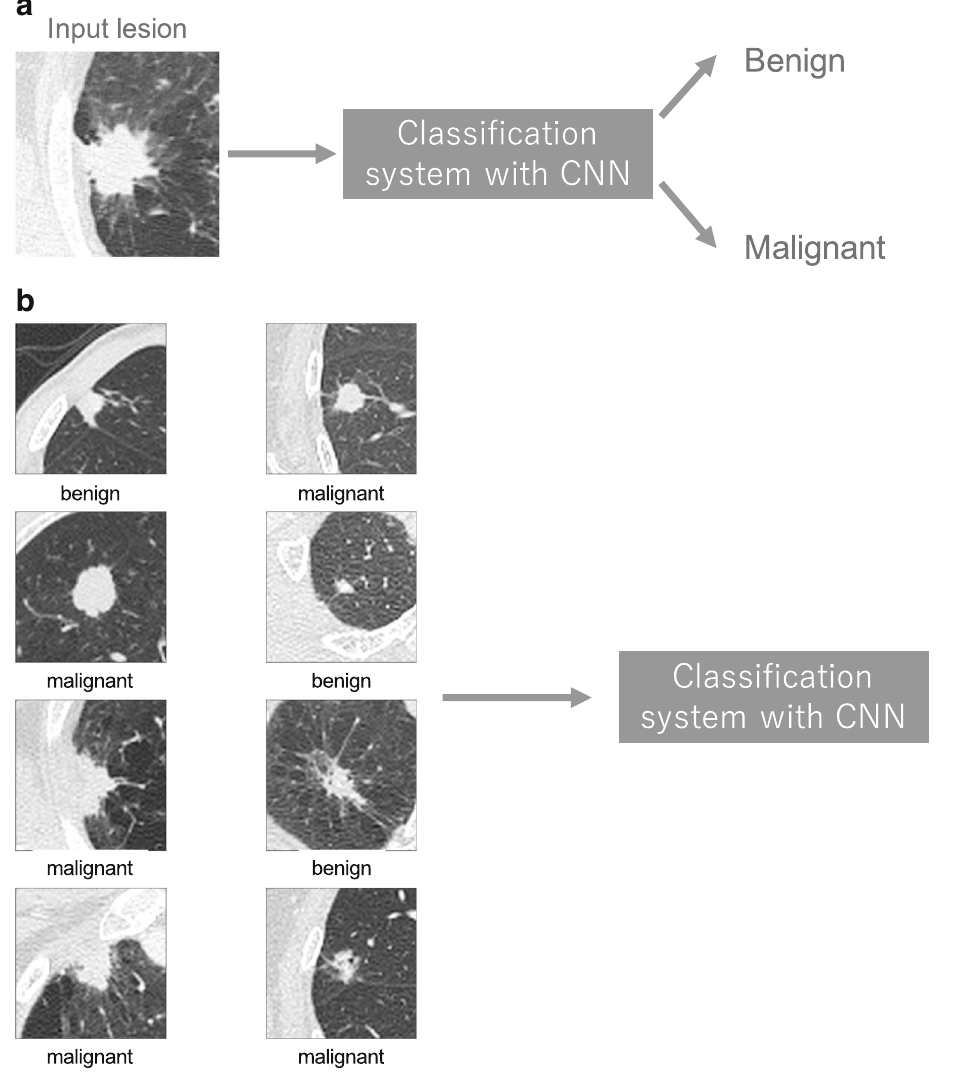
Fig. 11 A schematic illustration of a classification system with CNN and representative examples of its training data. a Classification system with CNN in the deployment phase. b , c Training data used in training